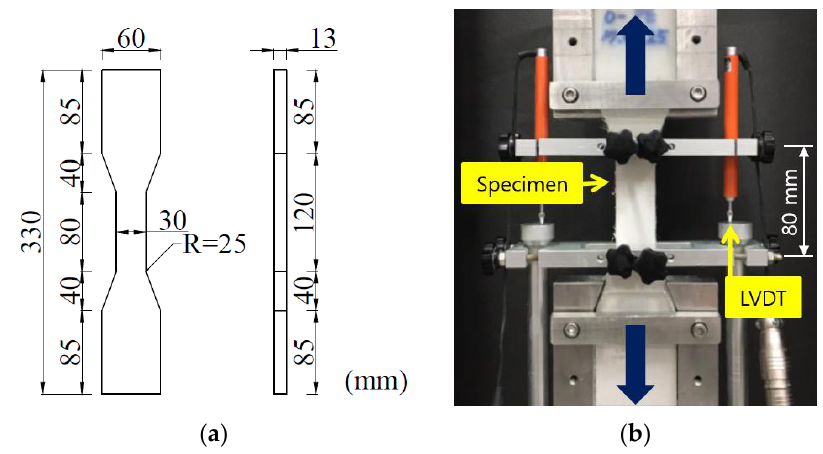
Figure 1. Uniaxial tension test: ( a ) dimensions of specimen and ( b ) test setup.